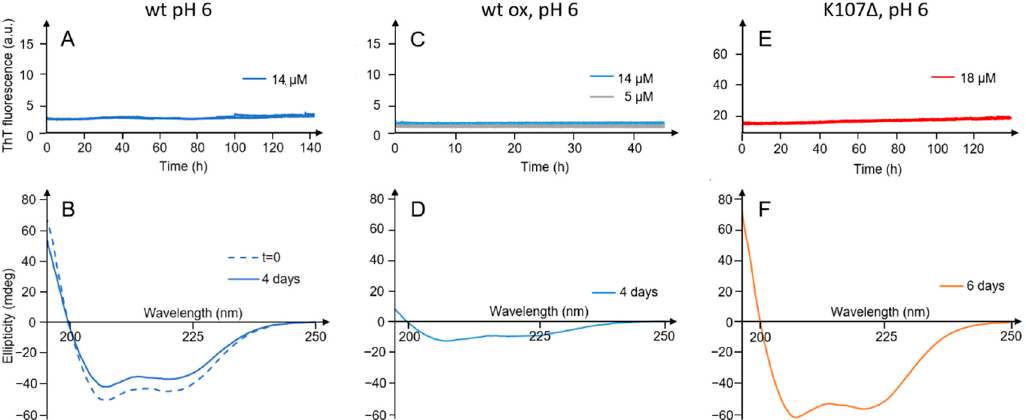
Figure 2. Time evolution of ThT fluorescence and CD spectra at pH 6.0. ThT fluorescence intensity versus time measured in duplicates in the presence of 14 µM ApoA-I wt ( A ), 5 and 14 µM oxidized ApoA-I wt ( C ) and 18 µM K107 Δ ApoA-I ( E ). CD spectra recorded for 11 µM wt ( B ), 5 µM oxidized wt ( D ) and 18 µM K107 Δ ( F ) at time zero (0 h) or at a later stage (4 or 6 days) as indicated in each panel.